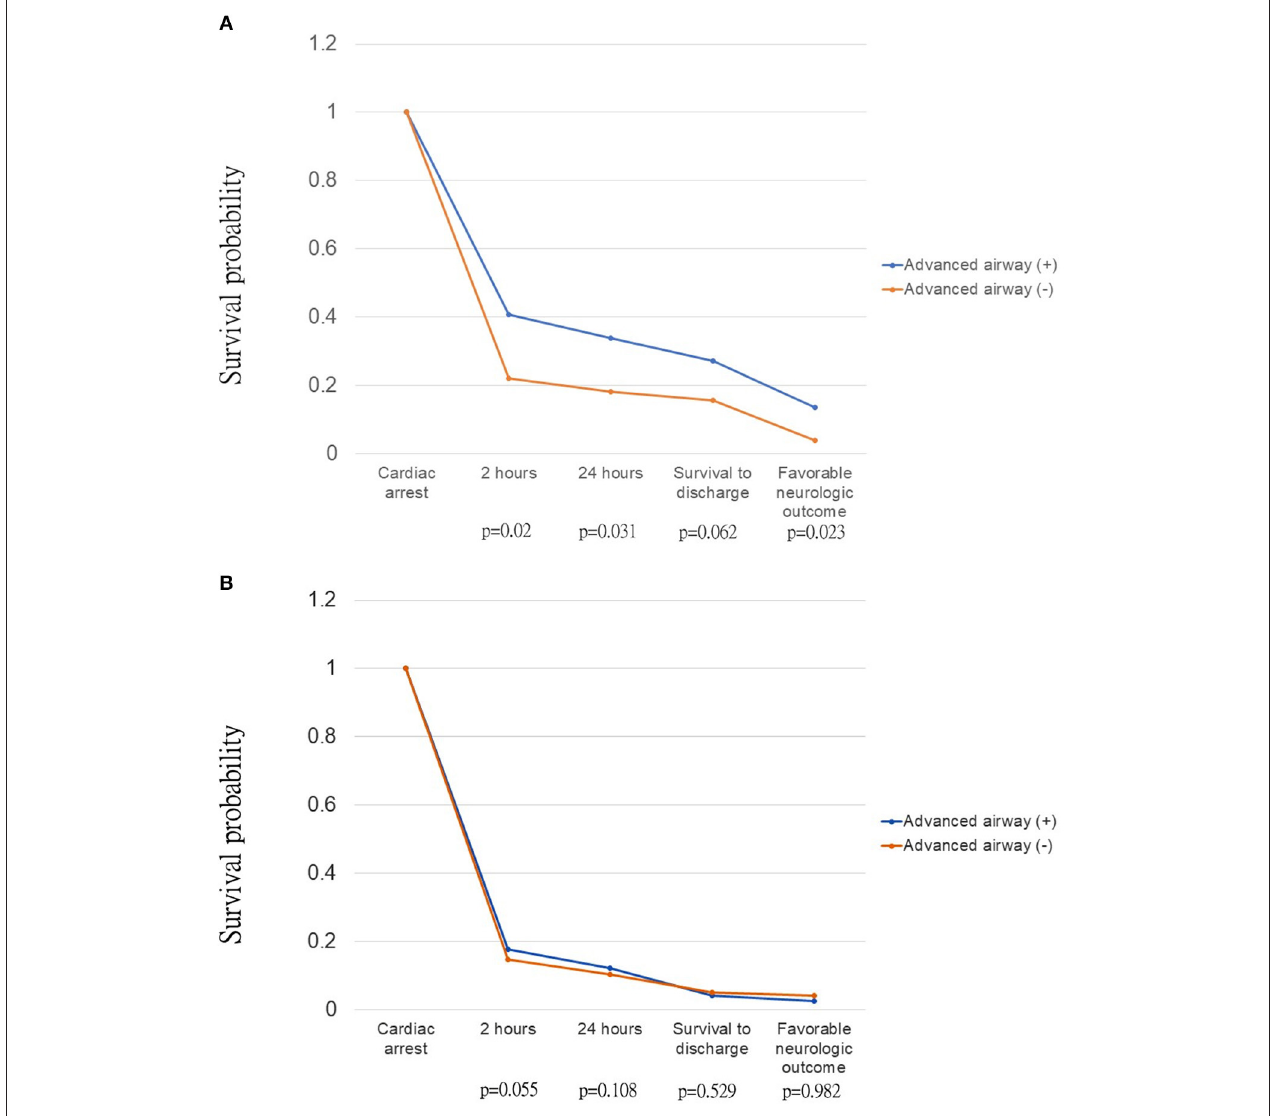
FIGURE 3 | Kaplan-Meier type plots with log-rank test for p- value of out-of-hospital cardiac arrest patients, stratified by advanced airway in (A) pediatric group; (B) adult